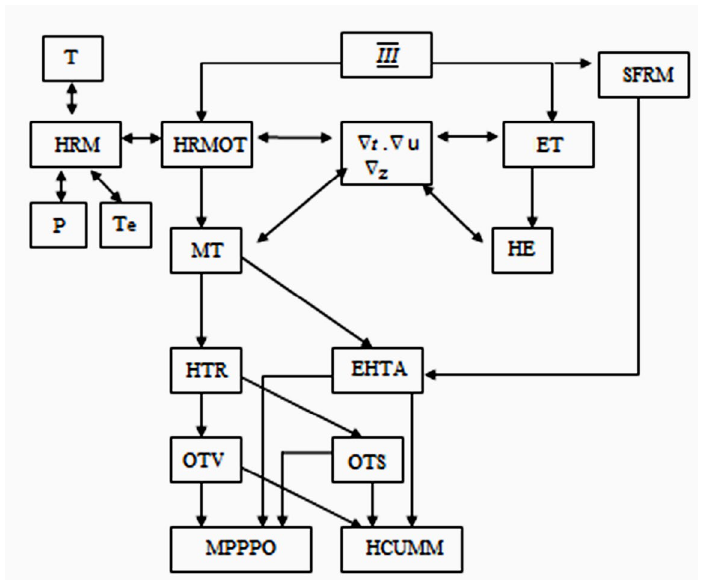
Fig. 3. Block diagram of physical and chemical effects (III) the hierarchy level of the system analysis of the process of degreasing raw materials and animal